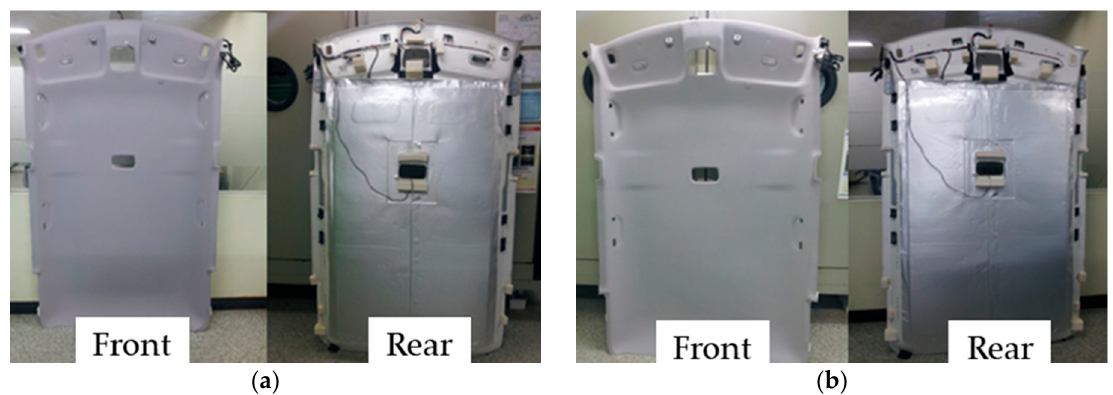
Figure 16. Prototype of the headlining reliability test: ( a ) Before; ( b ) After. Table 3. Headlining insulation performance evaluation result.